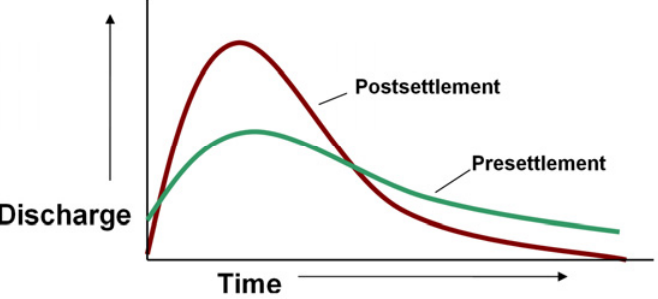
Figure 4. Historical alterations of stream discharge patterns in agricultural ecosystems (after